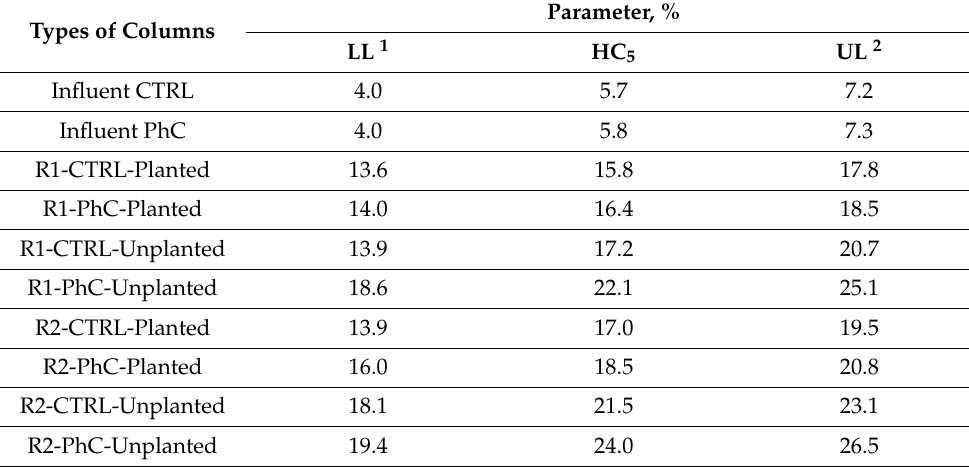
Table 5. HC 5 values for wastewater from